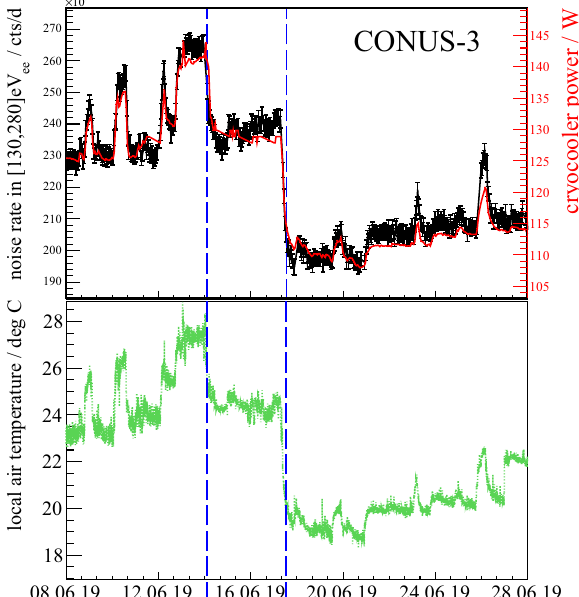
Fig. 14 C3detectorduringtheoutageof Run -2:Thelocalairtempera- ture, the cryocooler power consumption and the resulting noise integral in[130,280]eV ee areshown.Theyarestronglycorrelated.Thetwodot- ted blue lines reflect the installation and optimization of the so-called ‘cold-house’, which surrounds the Conus setup in room A408 of KBR